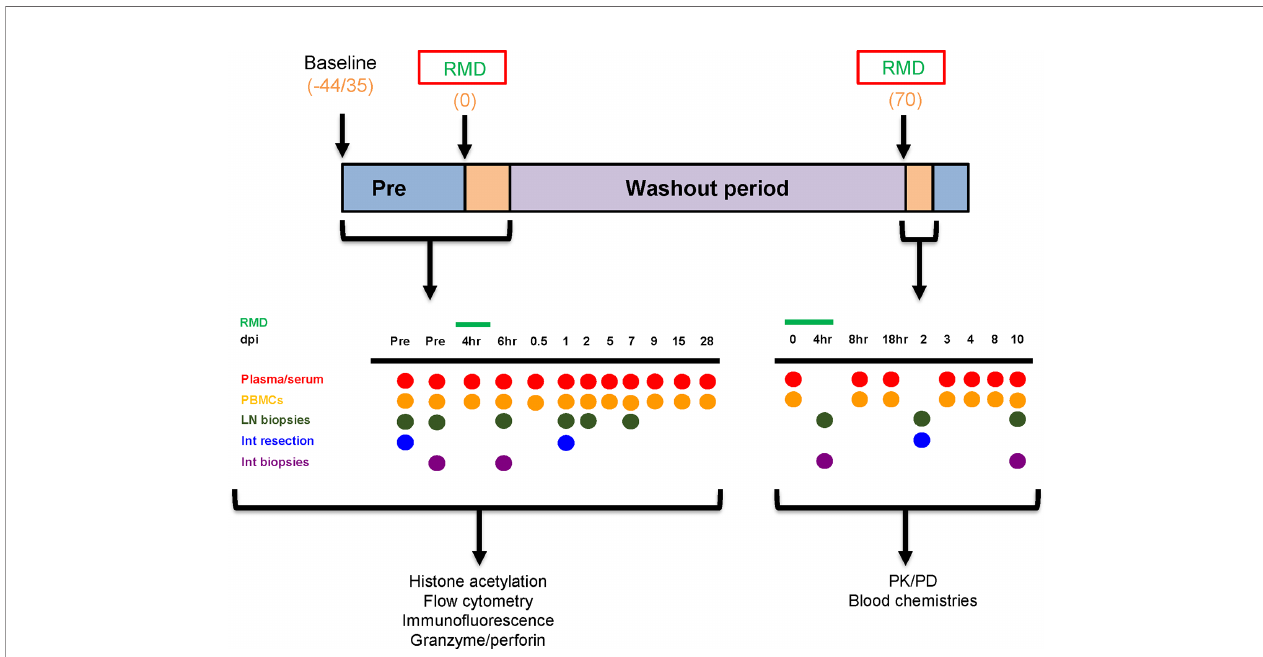
FIGURE 1 | Experimental design. The timeline denotes the days at which baseline measurements began, romidepsin (RMD) was administered, and the washout period, in days postinfusion. The sampling schedules for both the fi rst and second rounds of RMD treatment are shown. Blood chemistries, fl ow cytometry, immunohistochemistry, histone acetylation, and granzyme/perforin assays were completed with the samples taken from the fi rst round of RMD treatment. PK/PD of RMD in blood and tissues was assessed for the second round of RMD treatment. dpi, days postinfusion; PBMCs, peripheral blood mononuclear cells; LN, lymph node; Int,